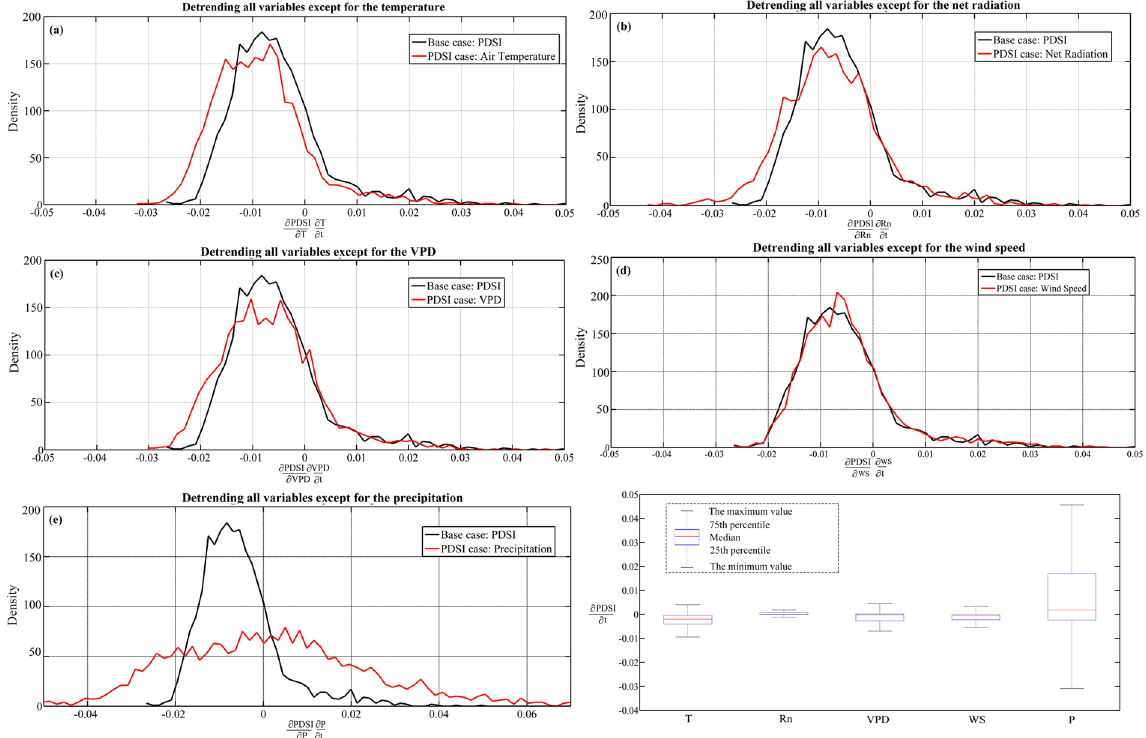
Figure 2. Quantifying the sensitivity of the changes in droughts over Central Asia using a series of numerical experiments. ( a ) The temperature case (detrending all variables except for the temperature): the probability density function (PDF) of the trends in the PDSI; ( b ) the net radiation case; ( c ) the vapour pressure deficiency case, ( d ) the wind speed case; ( e ) the precipitation case; ( f ) the summary of the contributions from different meteorological variables to the PDSI droughts. (Generated by Matlab 2012a, URL: http://cn.mathworks.com/